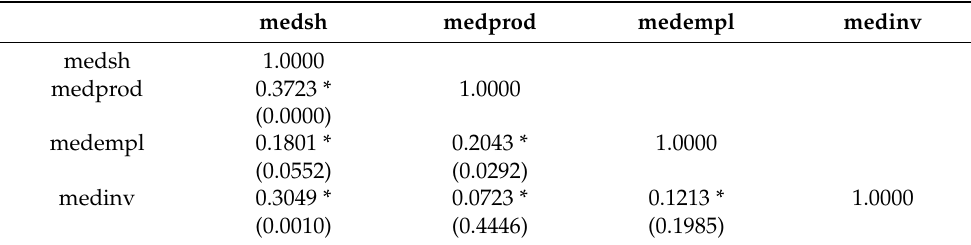
Table 3. Correlation